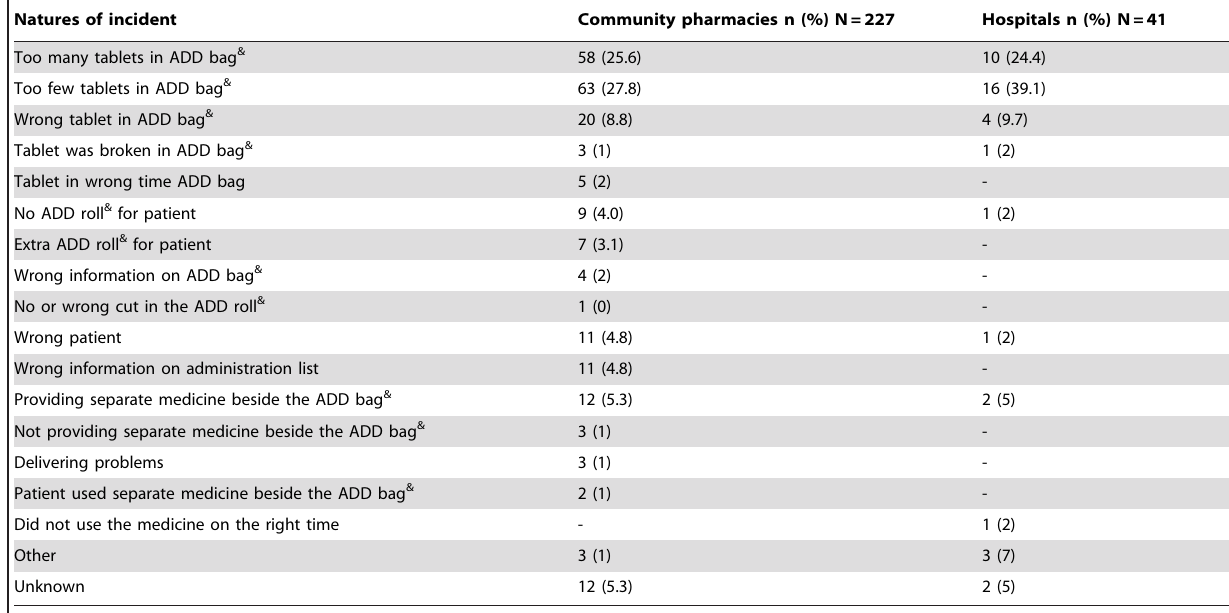
Table 3. Nature of incident from the patient’s perspective.